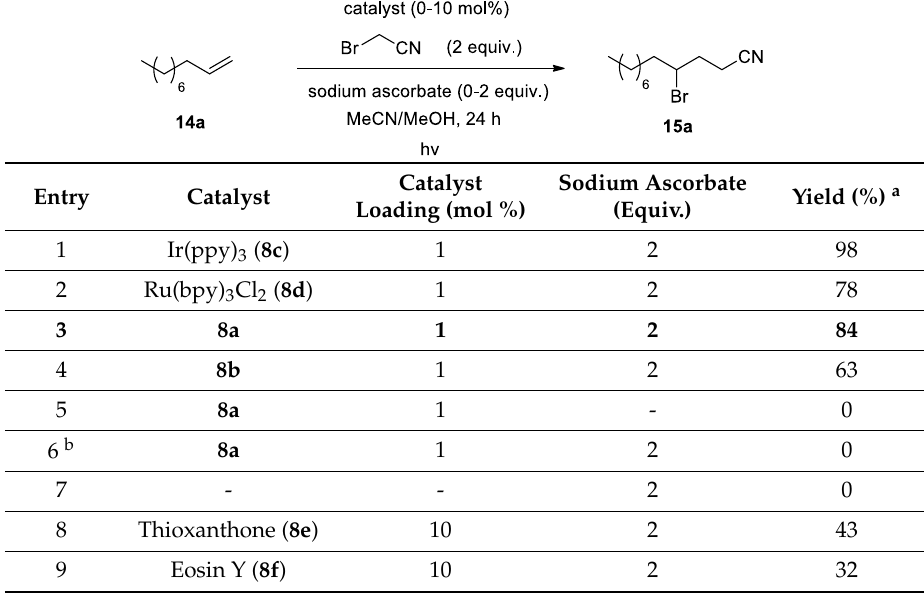
Table 1. Optimization of the reaction conditions for the photocatalytic atom transfer radical addition of bromoacetonitrile to olefins.